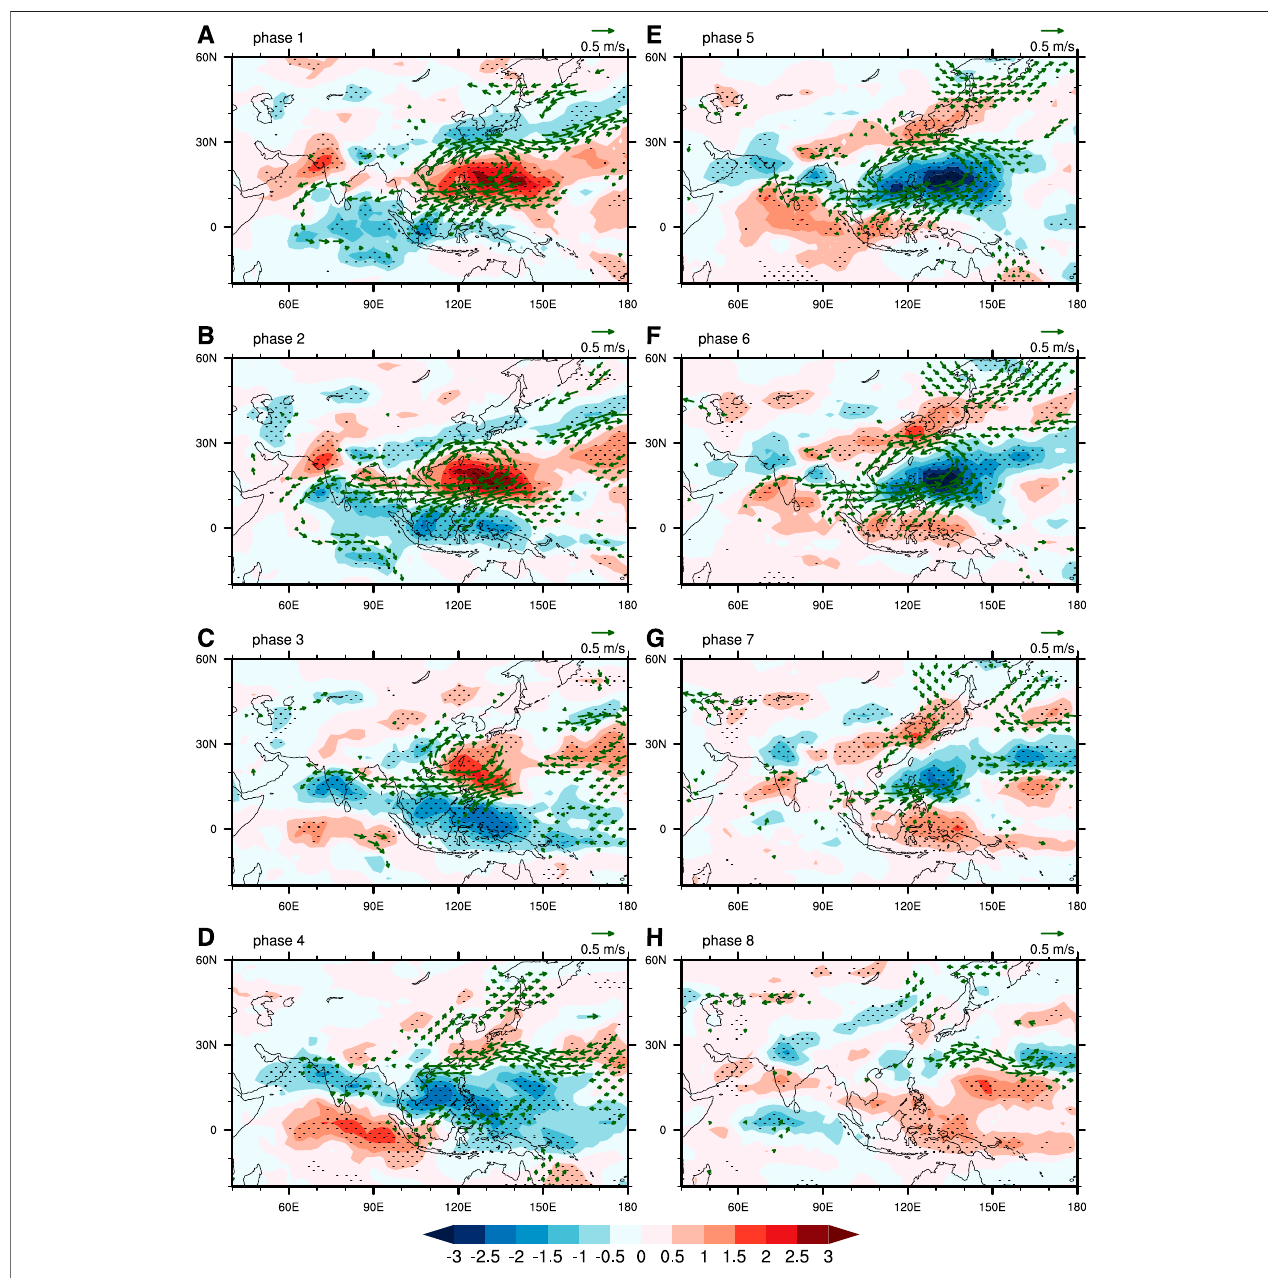
FIGURE 12 | As in Figure 9 , but for 40 – 50 days fi